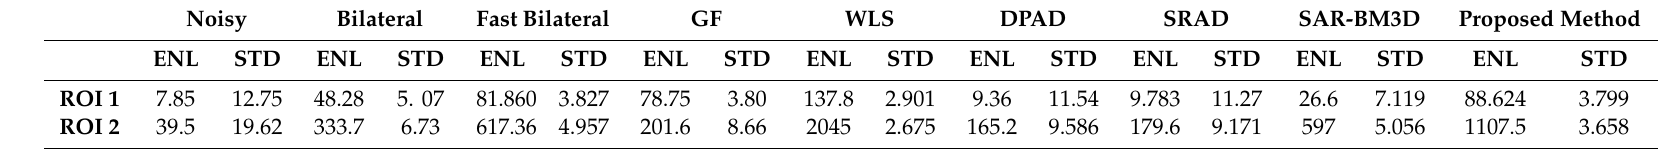
Table 8. ENL and STD results for SAR image